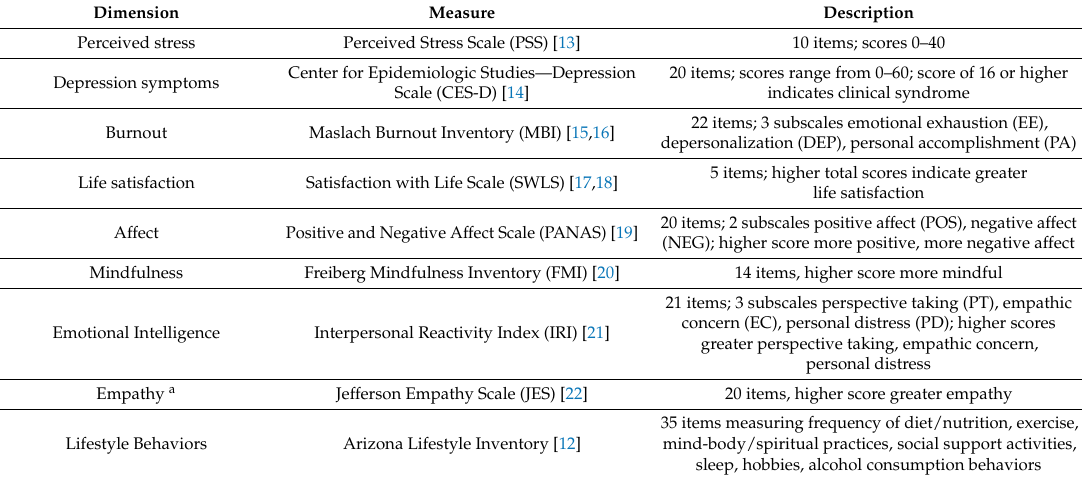
Table 1. Wellbeing